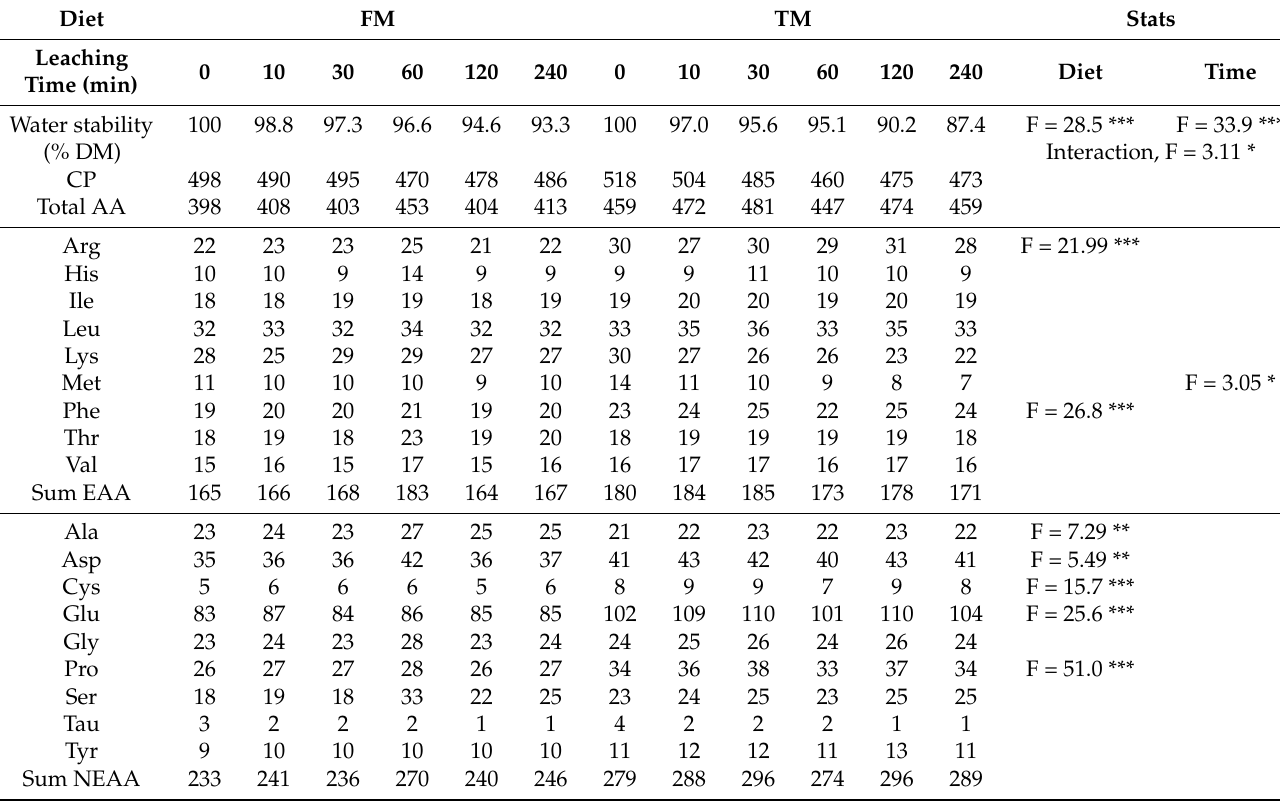
Table 3. Dry matter (DM), crude protein (CP), essential (EAA) and non-essential (NEAA) amino acid composition of two diets subject to various leaching periods in seawater. Data are means of three replicates and significant differences ( p < 0.05 *, p < 0.01 **, p < 0.001 ***) between diets and periods are noted (two-way ANOVA, p < 0.05). Data in g kg − 1 DM basis unless otherwise